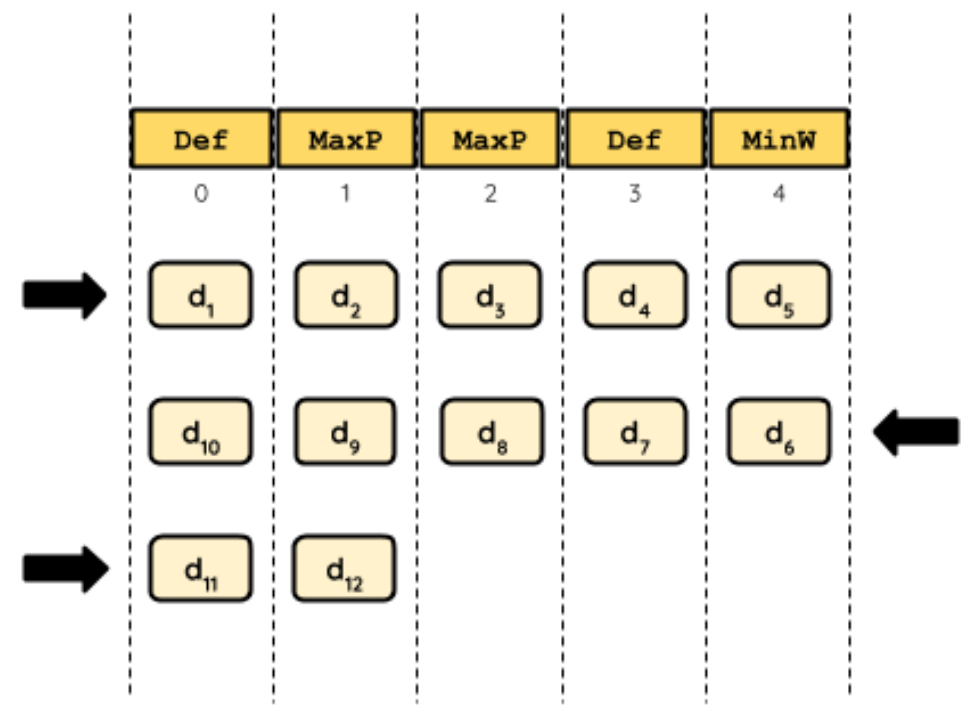
Figure 1. An example of a hyper-heuristic with a cardinality of five, and the way it solves an instance with 12 items. Black arrows indicate the direction in which heuristics are selected to make a